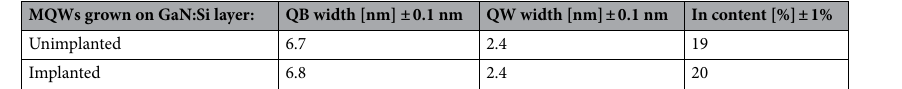
MQWs grown on GaN:Si layer: